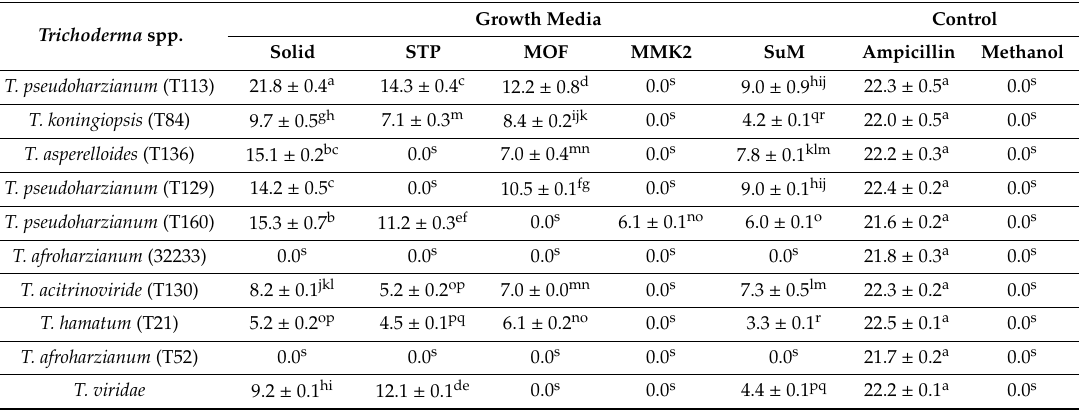
Figure 1. Zone of bacterial growth inhibition (mm) produced by secondary metabolites (SMs) of T. pseudoharzianum (T113) obtained on different growth media (1) Solid; (2) STP; (3) MOF; (4) MMK2; (5) SuM; (6) negative control, methanol; (7) positive control, ampicillin; ( A ) well diffusion method: ( A1 ) R. solanacearum; ( A2 ) X. compestris ; ( B ) disc diffusion method: ( B1 ) R. solanacearum ; ( B2 ) X. compestris . Table 1. Growth inhibition (mm) of R. solanacearum affected by SMs (obtained on different growth media) of Trichoderma spp. evaluated through the well diffusion method.